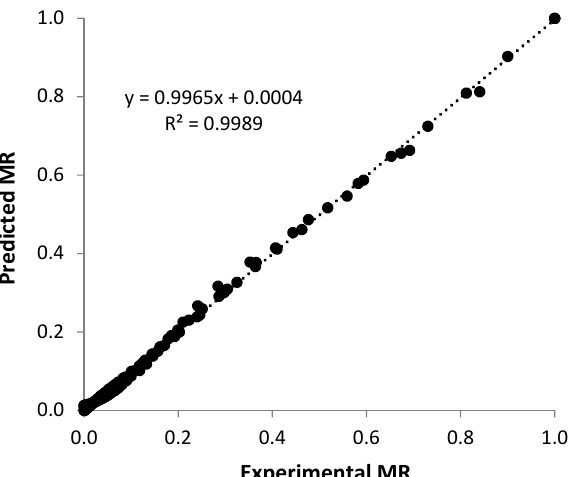
Figure 6. Experimental versus Predicted Moisture Ratio values for pumpkin seeds dried at constant air velocity of 2.87 m/s.